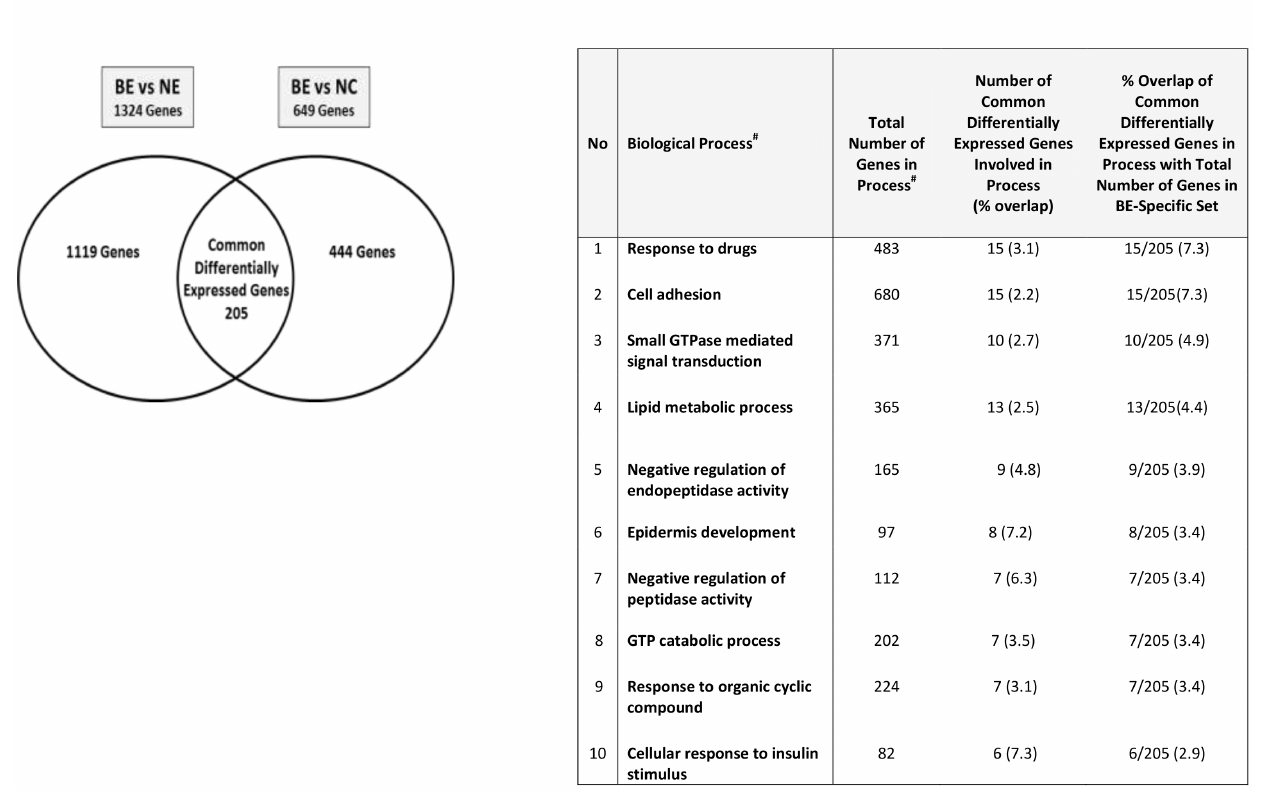
Figure 2. Paired analyses of significant differential gene expression ( $ 2 fc and P , 1.12E-06) in BE vs NE and BE vs NC and enrichment in known biological processes. A. The left Venn diagram represents the total number of genes with significant differential expression between BE and NE ( $ 2 fc and P , 1.12E-06), whereas the right Venn diagram represents the total number with genes significant differential expression between BE and NC ( $ 2 fc and P , 1.12E-06). The overlap between the two differentially-expressed sets contained 205 genes used for functional classification and pathway-based analyses. B. Enrichment of the 205 genes in known biological processes (GO, Ariadne Genomics, MD). The columns entitled: ‘Total no of genes in process’ and ‘Number of genes involved in process (% overlap)’ refer to the total number of genes currently known in each process according to the database (Pathway Studio 9.00), and the % overlap of the 205 genes with the total gene number in each process, respectively. Enrichment of the 205 genes identified in each process relative to the whole gene set is also shown. The largest proportion of genes (7.3%) out of the 205 genes were involved in response to drugs and cell adhesion; however, relative to the overall number of genes in the identified process, cellular response to insulin showed the greatest enrichment.